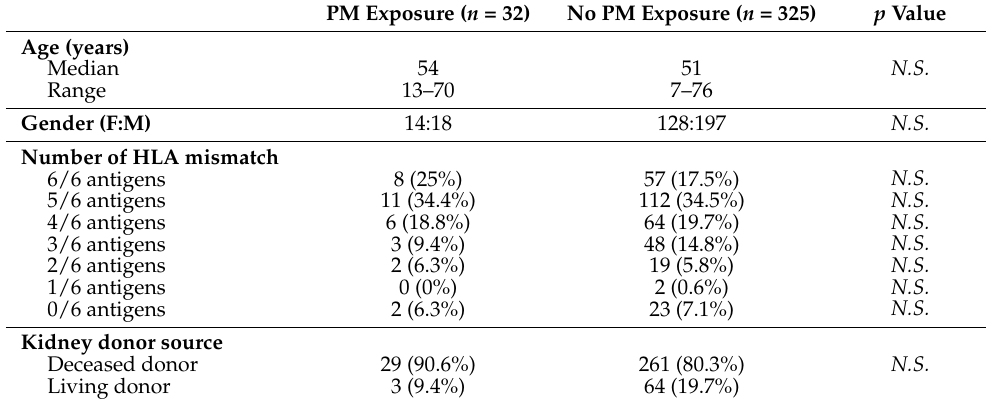
also not any significant difference in the rates of AGR during first year after transplant between those who received deceased donor kidneys and those who received living donor kidneys (6.6% vs. 10.4%, N.S .). Similarly, the increased risks for AGR development during the first year after transplant associated with the use of PM BSA were observed in the entire group of patients, irrespective of the source of the donor grafts (Figure 4).